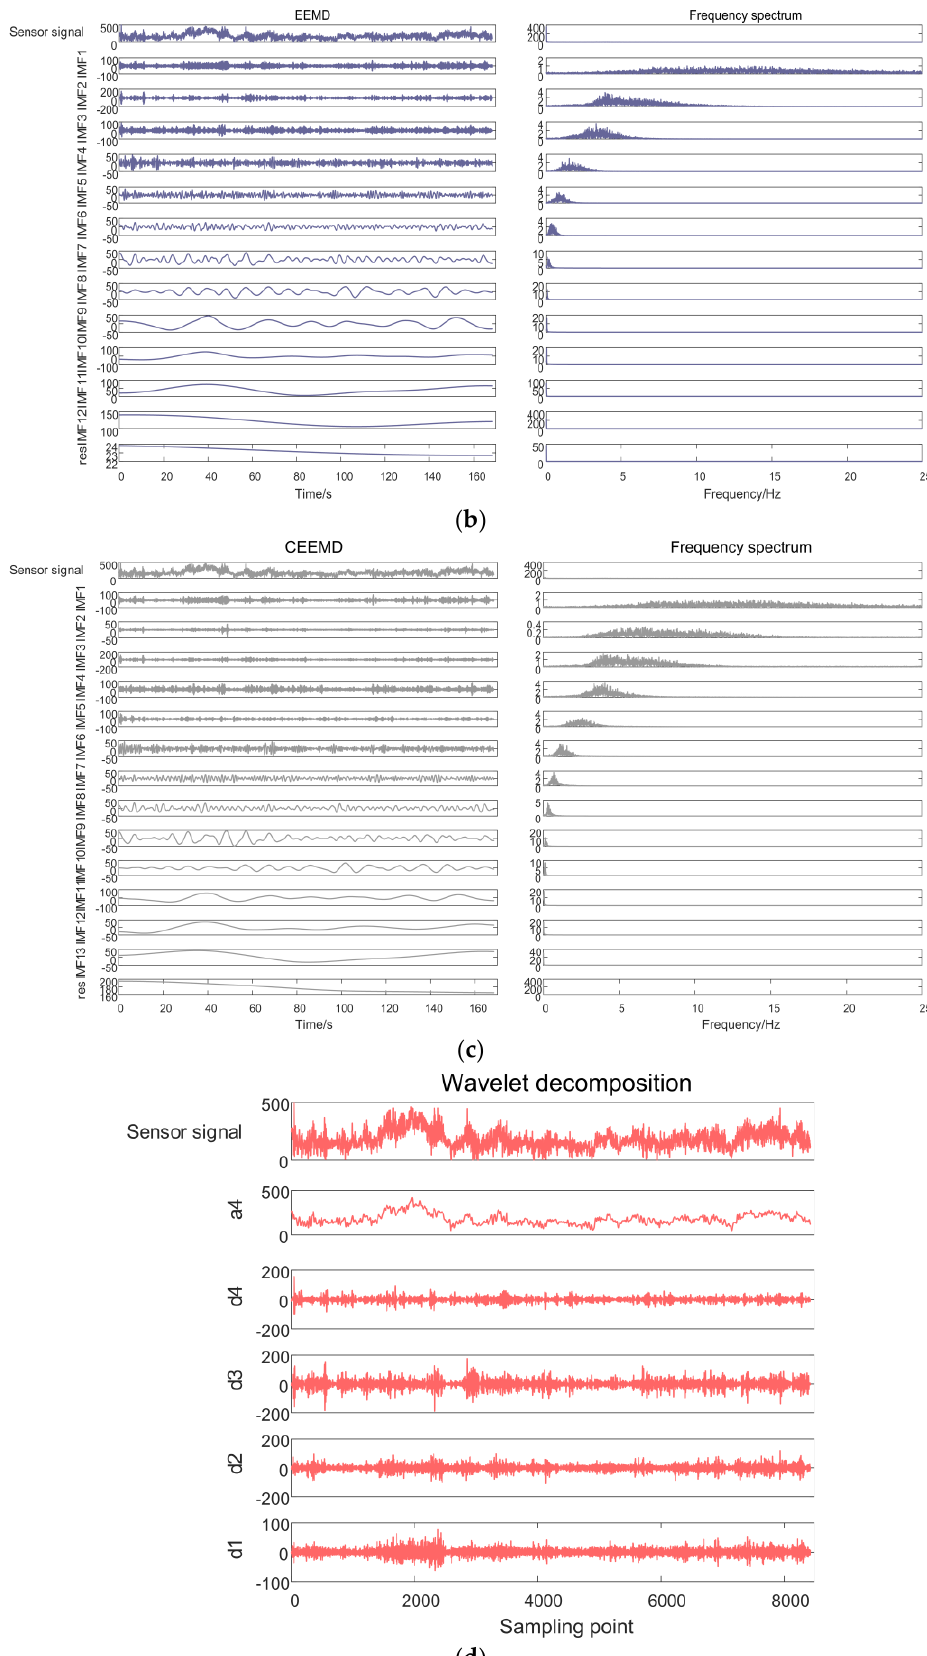
Figure 16. Sensor signal decomposition: ( a ) EMD; ( b ) EEMD; ( c )CEEMD; and ( d ) wavelet.